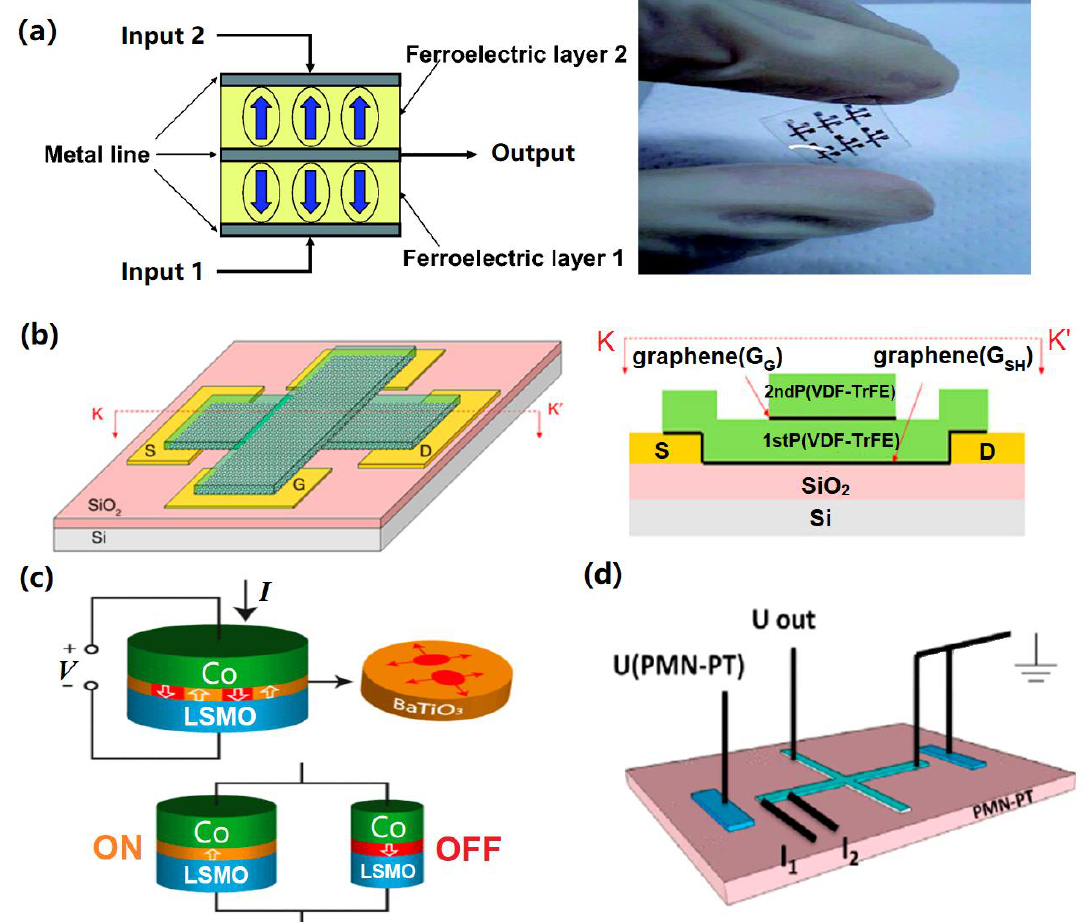
Figure 4. More advanced approaches to FeRAM devices: ( a ) the cross-sectional geometry of an FePLG (ferroelectric programmable logic gate) (left) and a photograph of an FePLG fabricated on a flexible substrate (right); ( b ) the three-dimensional geometry of a graphene field-effect transistor (left) and its cross-sectional view (right); ( c ) the structure of a ferroelectric tunnel memristor; ( d ) a schematic of the device structure for logic gates. (( a ) is reprinted with permission from [50]; ( b ) is reprinted with permission from [51]; ( c ) is reprinted with permission from [52]; ( d ) is reprinted with permission from [53].)